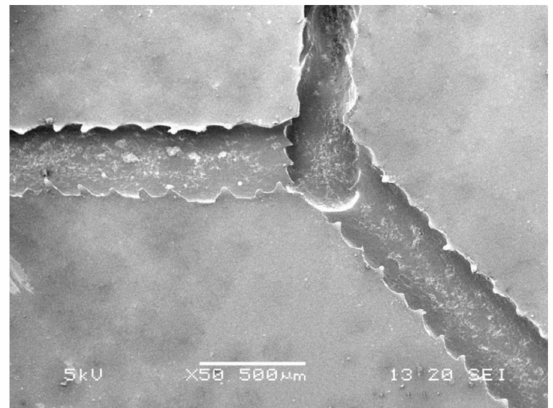
Figure 9. SEM photo of the intersection area of the PDMS